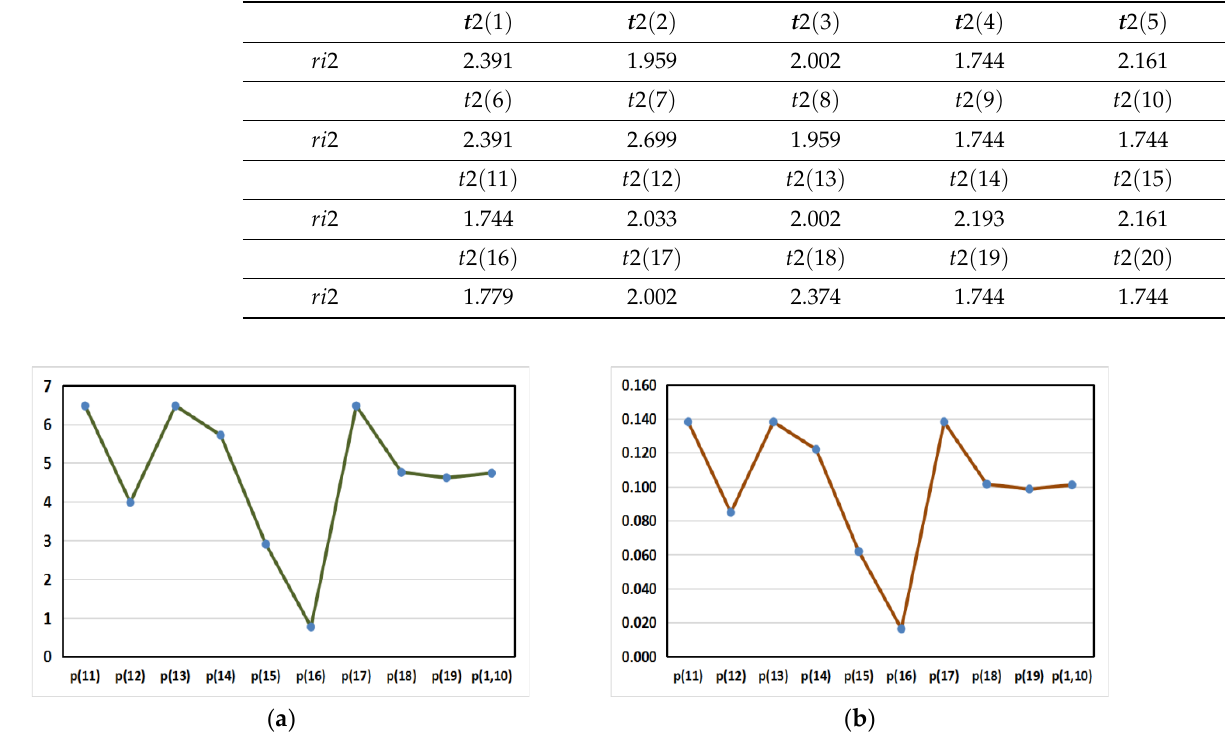
Table 5. Recommendation function value ri 2 of each water scenic spot.